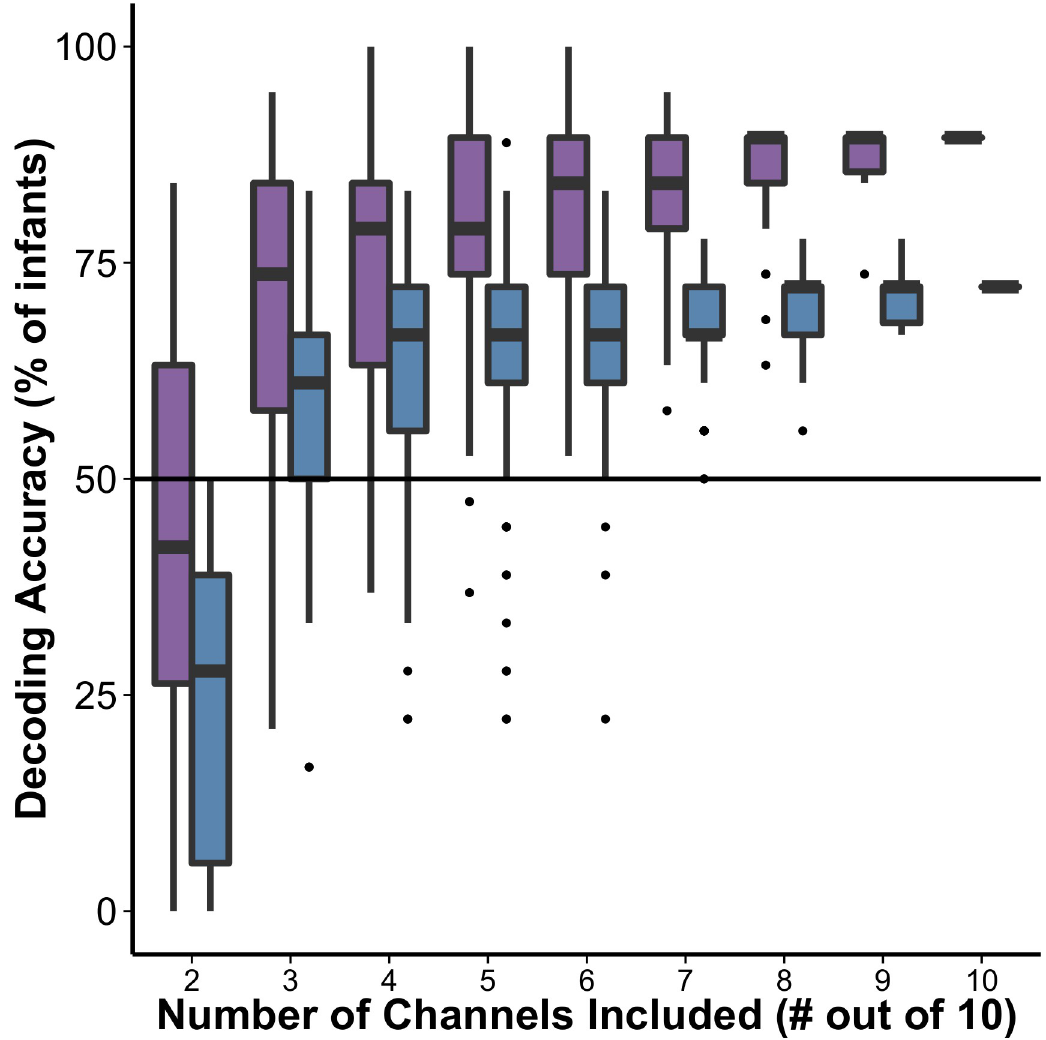
Fig 4. Decoding accuracyof infant-level activation patterns by subset size for Datasets#1 (purple boxes) and #2 (blue boxes). Far right, decoding using three most informative channels (most informative channels determined using subset size 2, Fig 3). Note: For the subset size of 10 channels,there is only one subset and so there is no range to